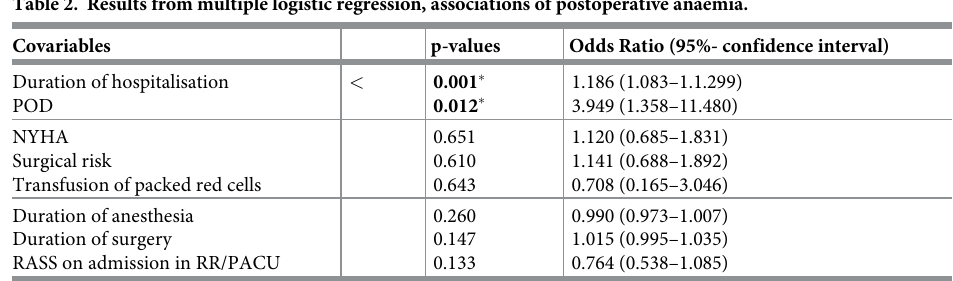
Table 2. Results from multiple logistic regression, associations of postoperative